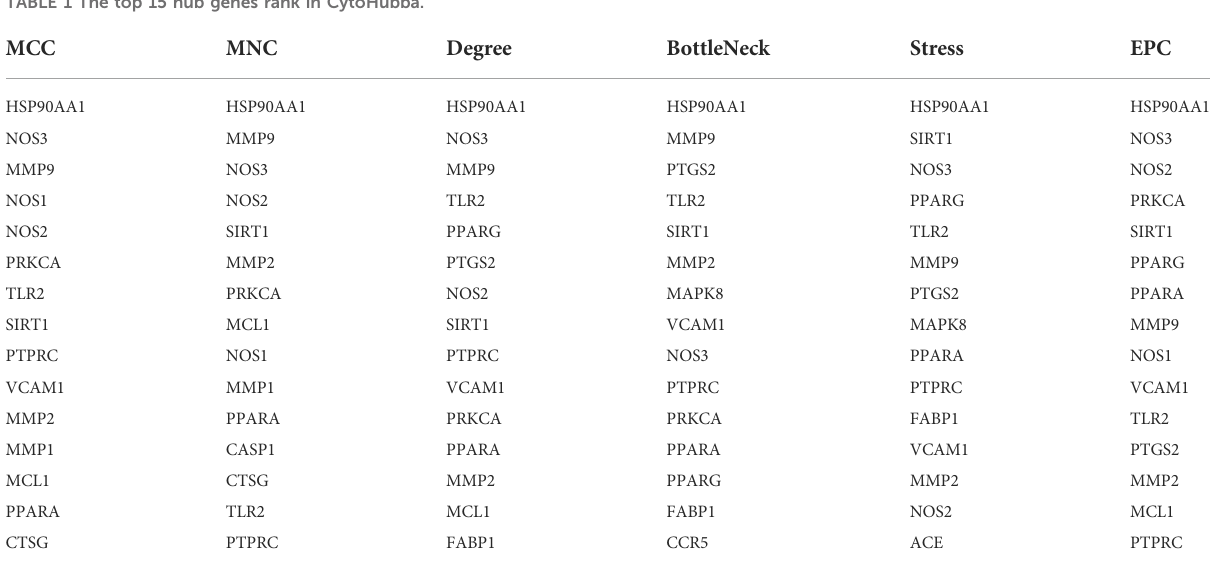
TABLE 1 The top 15 hub genes rank in CytoHubba. MCC MNC Degree BottleNeck